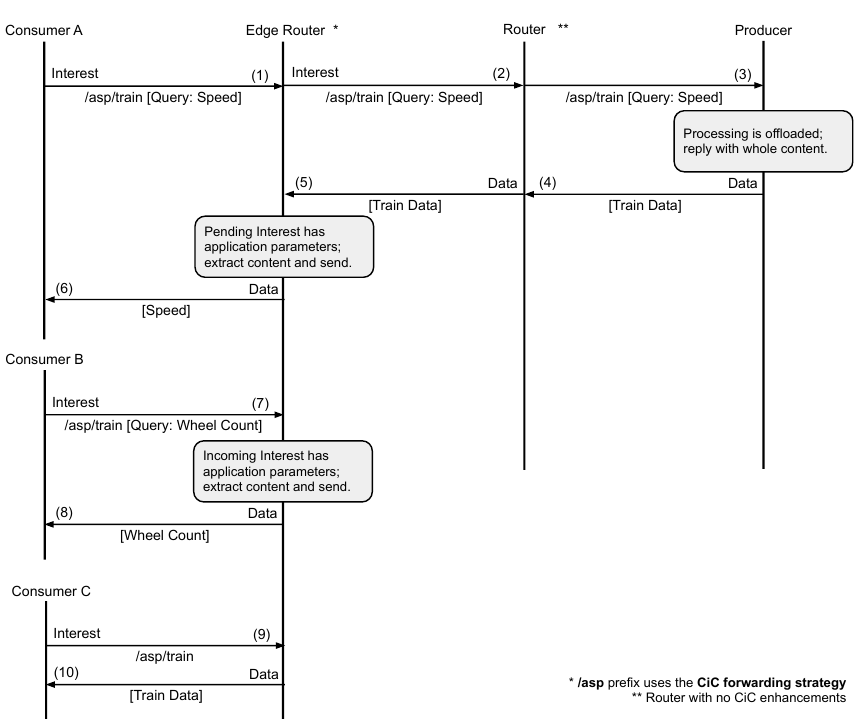
Figure 5. CiC forwarding: ( a ) Interest processing pipeline; ( b ) Data processing pipeline.